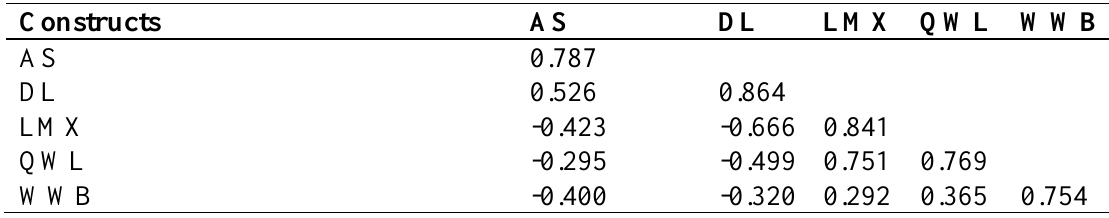
Table 3. Fornell-Larcker Criterion